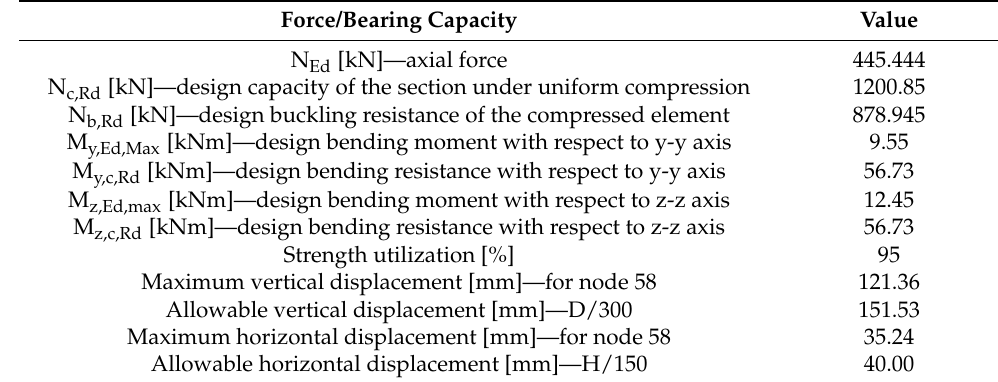
Table 2. Values of the internal forces, capacity of the most stressed element of the structure (bar no. 212 in the meridian line), and the maximum horizontal and vertical displacement of node